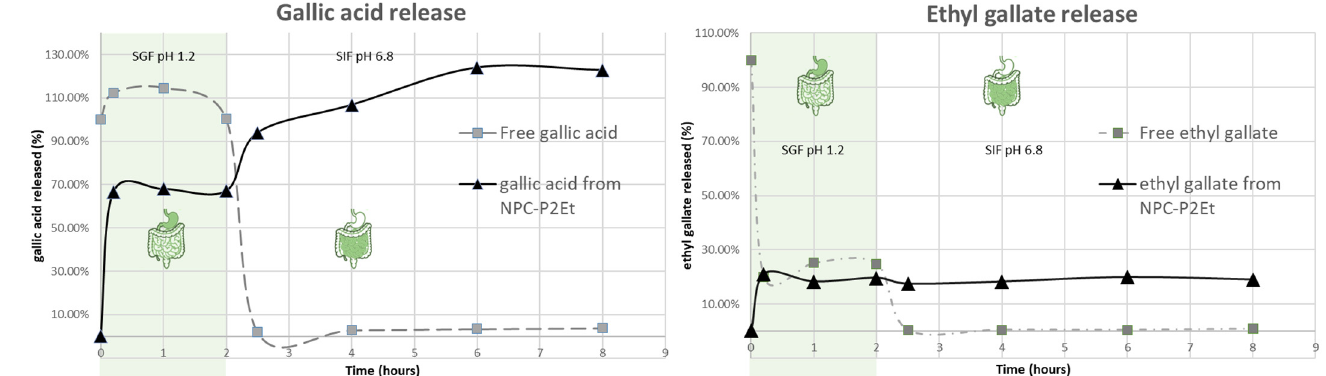
Figure 2. Behavior of P2Et in simulated gastric fluid and simulated intestinal fluid. The left graph shows the concentration over time of gallic acid in both fluids in the free P2Et form (square and grey line) and the encapsulated form (triangle and black line). On the right graph the behavior of ethyl gallate over time is shown. The free P2Et form is shown as a square and grey line while the encapsulated form is shown as a triangle and black line. Results from n = 1 test.